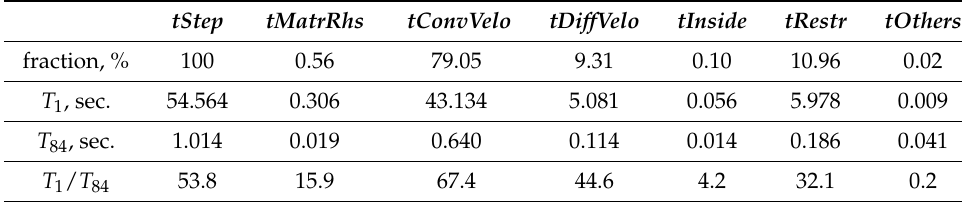
Table 4. Speedup of VM2D algorithm operations using MPI.